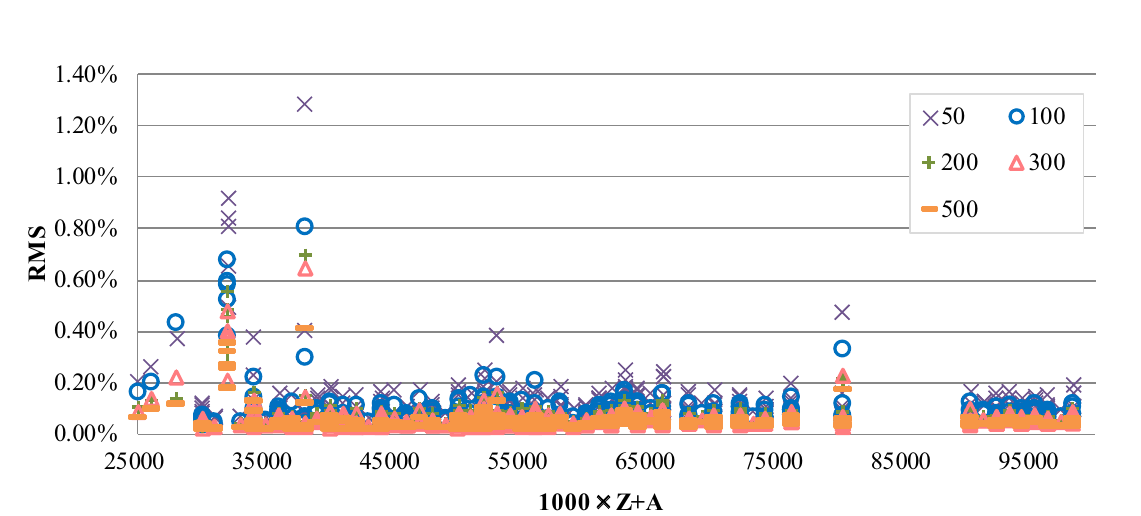
Figure 3. RMS values of probability table difference in each ladder number (elastic scattering).